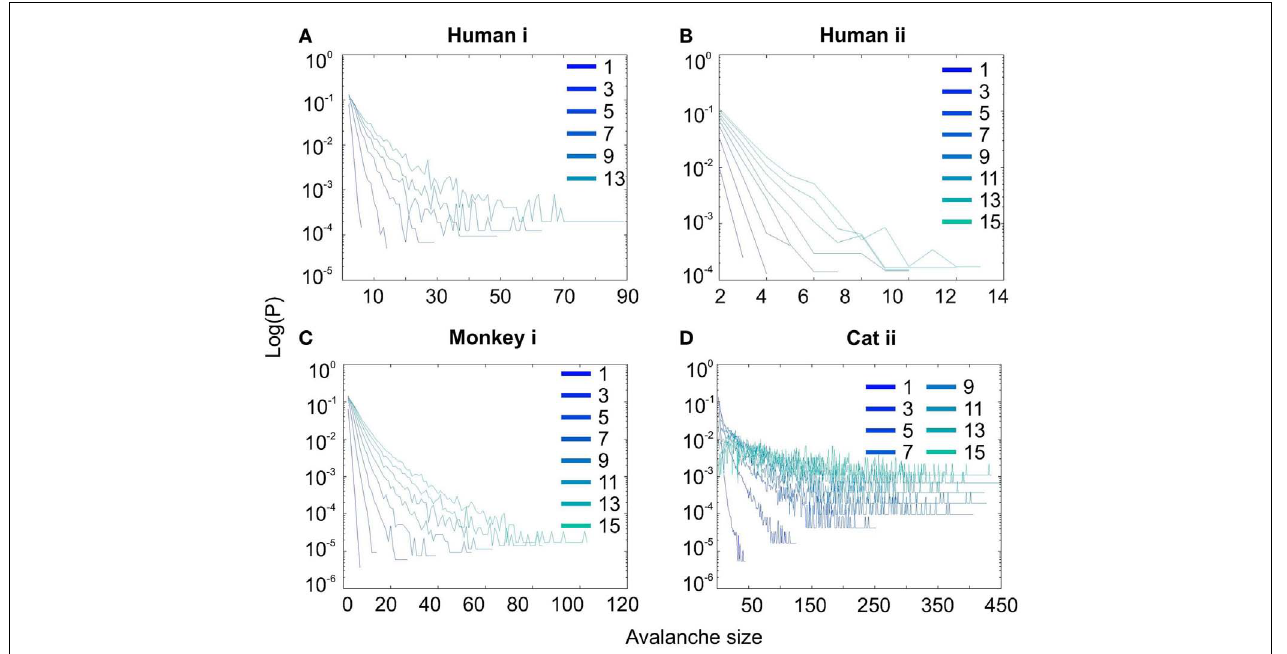
log-linear scale. Spike avalanches for all coarse graining levels, showed a linear trend. Please notice that bin sizes 11 and 15 are not shown because for the clarity in the line plot, but showed similar linear trend in this scale (not